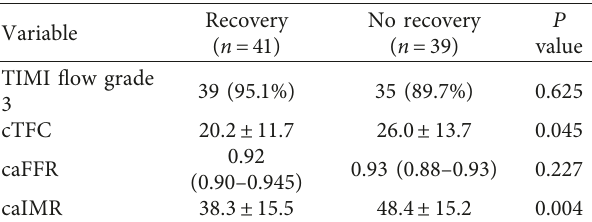
Table 3: Measures of microvascular function in patients with and without left ventricular recovery at 3 months.